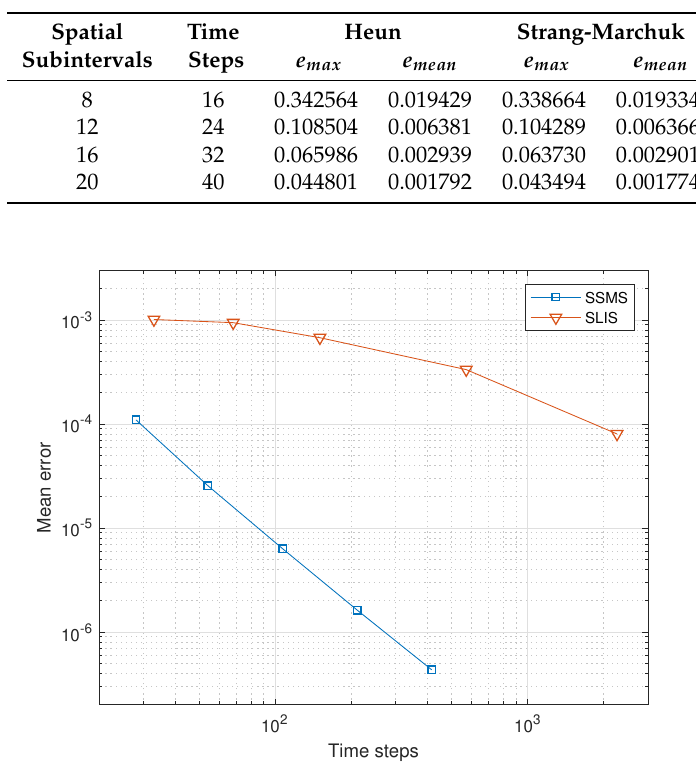
Figure 3. Mean error e mean of the shifted Strang-Marchuk splitting (SSMS) and the shifted linear iterative splitting (SLIS) for the CDR equation for different tolerances, η